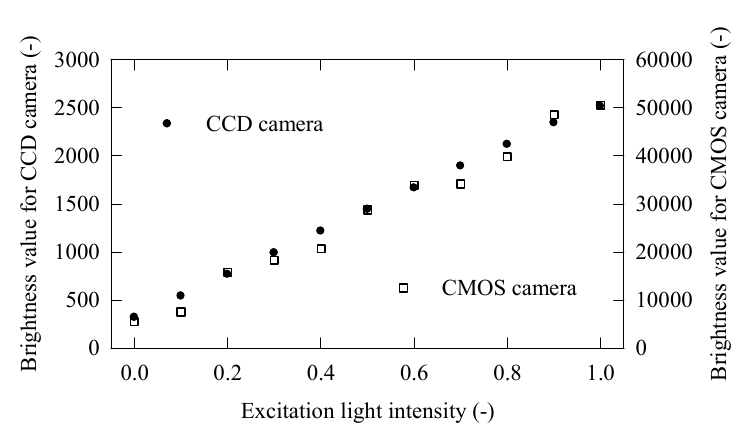
Figure 4. Sensor linearity of CCD and CMOS cameras. Detected brightness values were plotted against excitation light